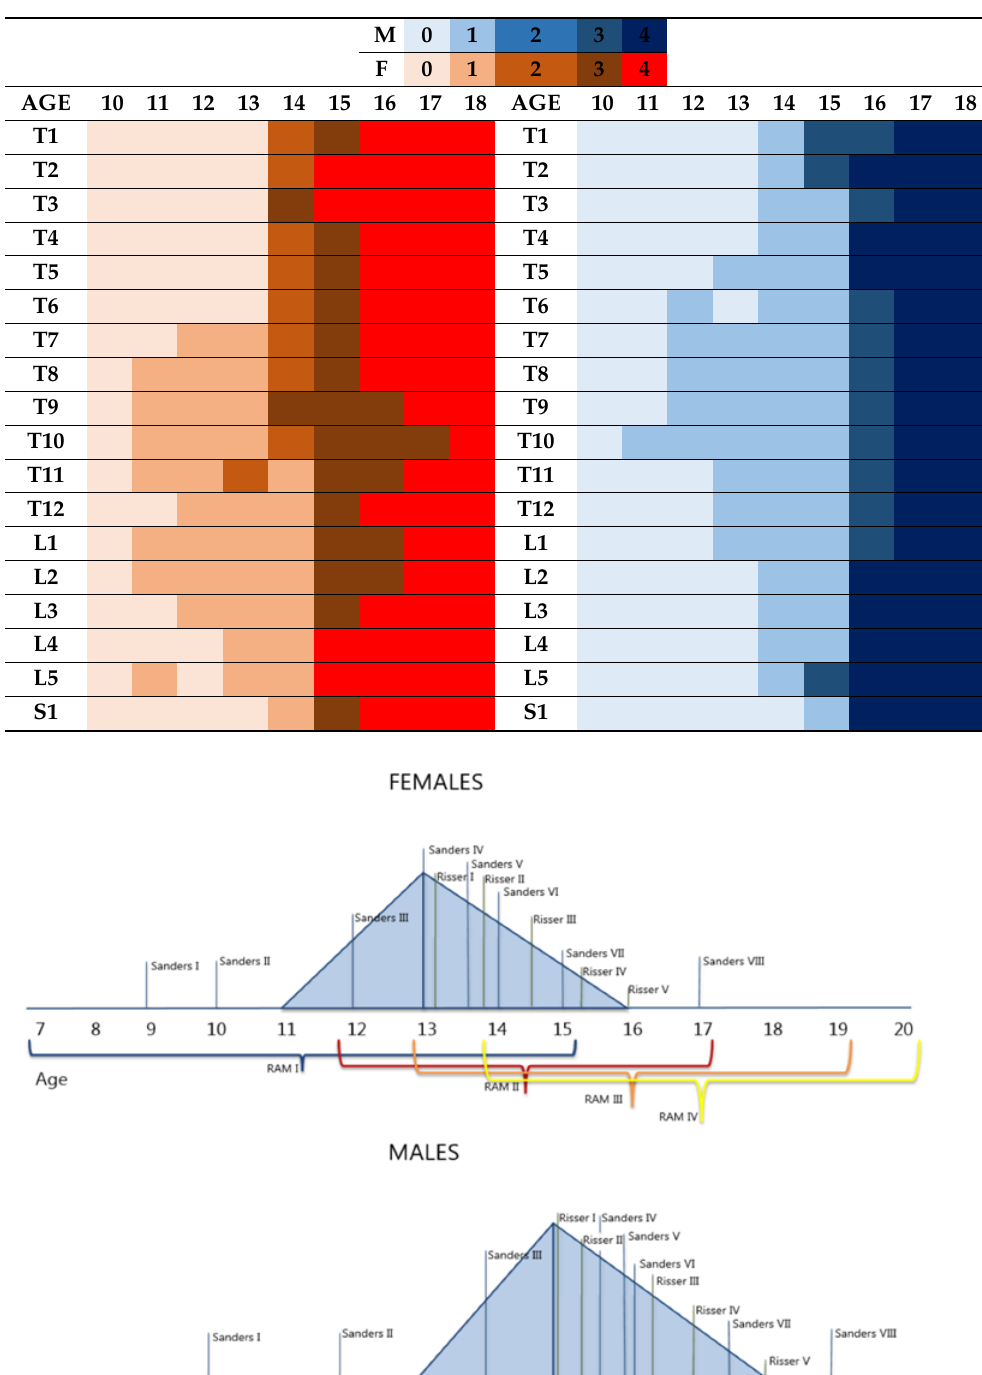
Table 2. The differences in mean maturation of the apophyseal ring in males (in blue) and females (in red) for each spinal level.